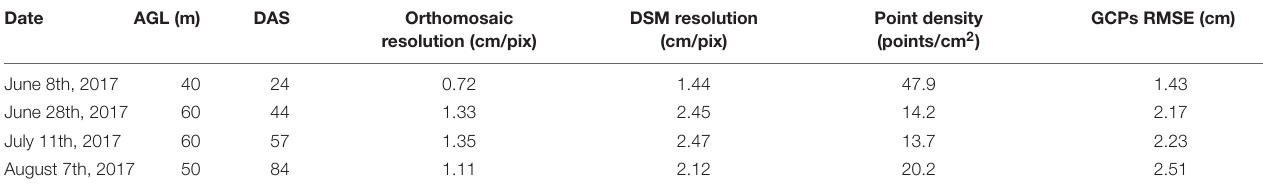
TABLE 1 | Details of UAV-HTPP image